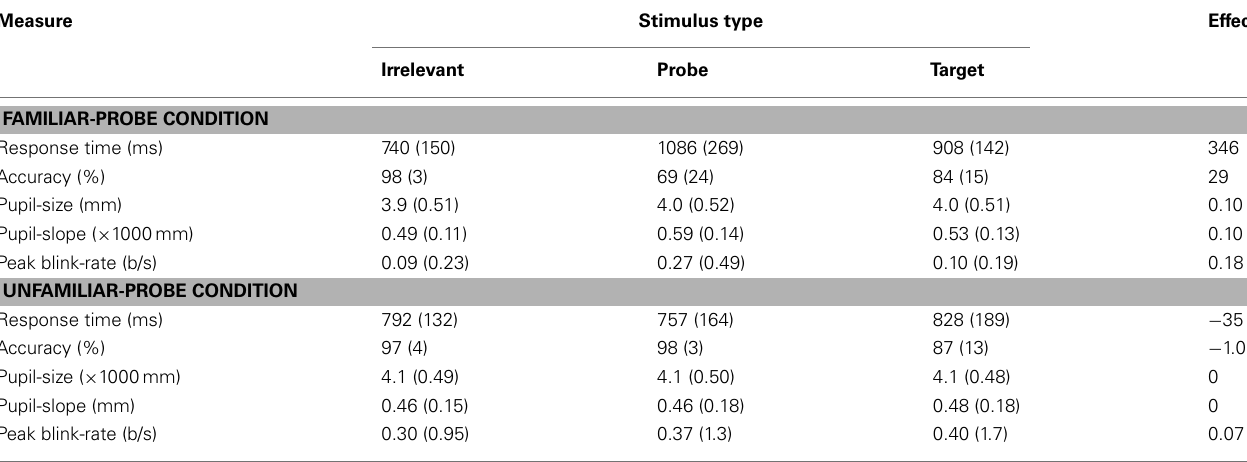
Table 1 | Mean un-standardized data by stimulus type and condition for each